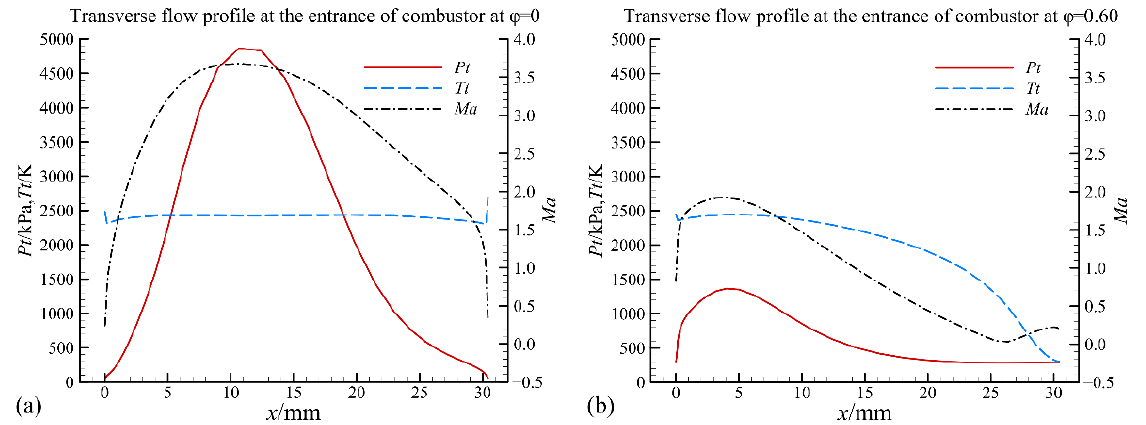
Figure 7. Transverse flow profile at the entrance of the combustor. ( a ) Flow quantities at the entrance of combustor at a fuel equivalence ratio of 0; ( b ) flow quantities at the entrance of the combustor at a fuel equivalence ratio of 0.6.